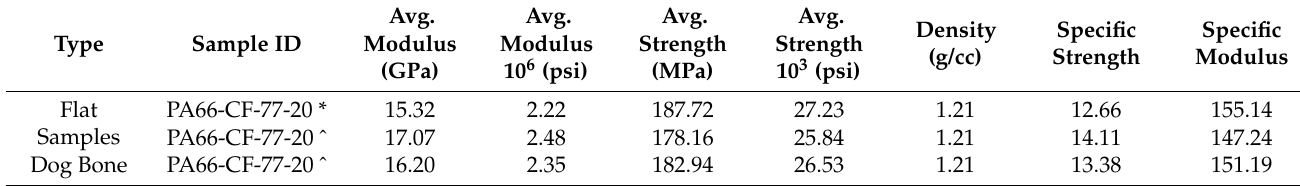
Table 4. Tensile modulus and strength of C/PA66 (preform ‘Roll’).